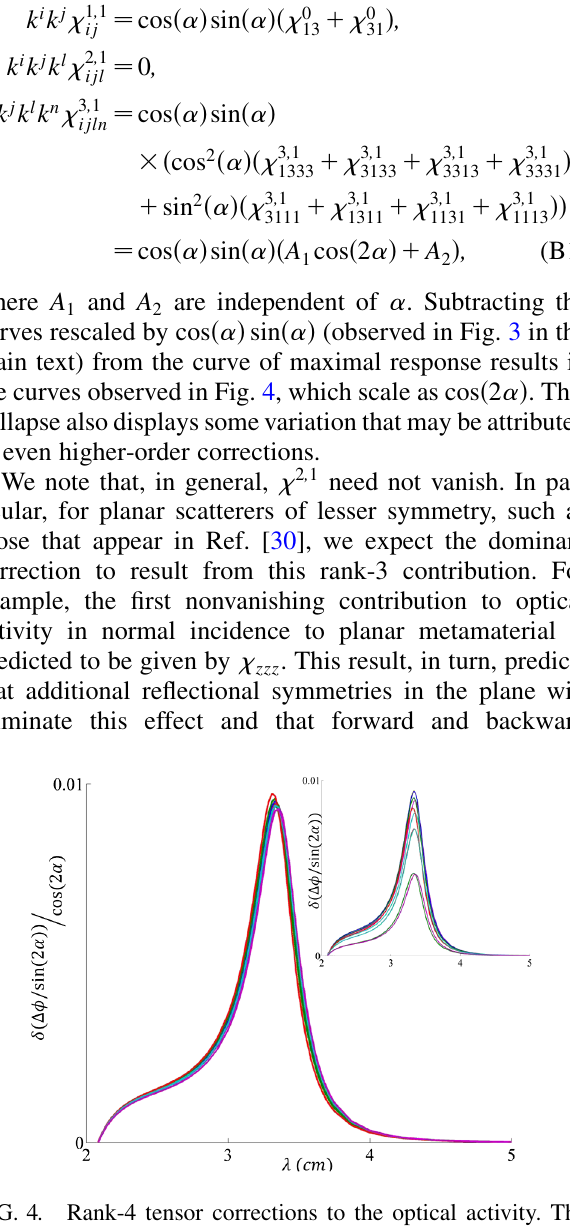
FIG. 4. Rank-4 tensor corrections to the optical activity. The difference between the collapsed curves in Fig. 3 of the main text is observed mostly around the resonant peak, and it is about an order of magnitude smaller than the peak value (inset).